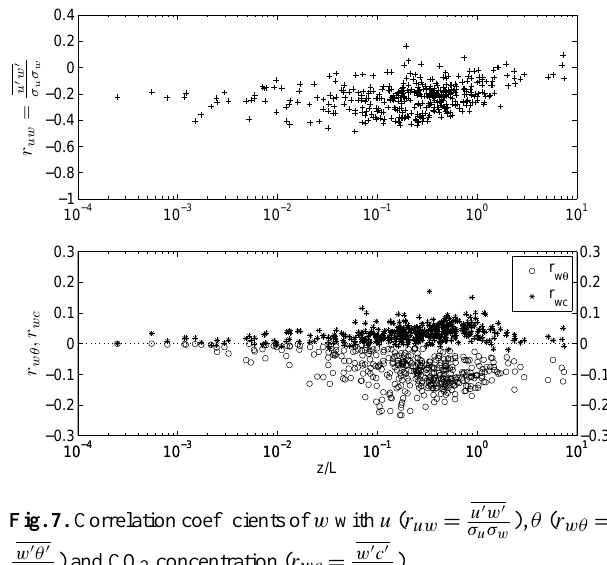
Fig. 6. Correlation coefficients of w with u ( r uw = u ′ w ′ σ Fig. 7. Correlation coefficients of w with u ( r uw = u